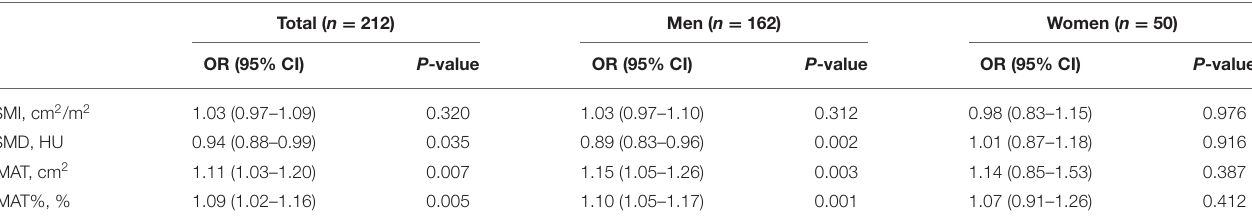
TABLE 3 | Multivariate logistic analyses to explore the association of ADL disability with skeletal muscle mass and muscle quality indicators measured by chest CT